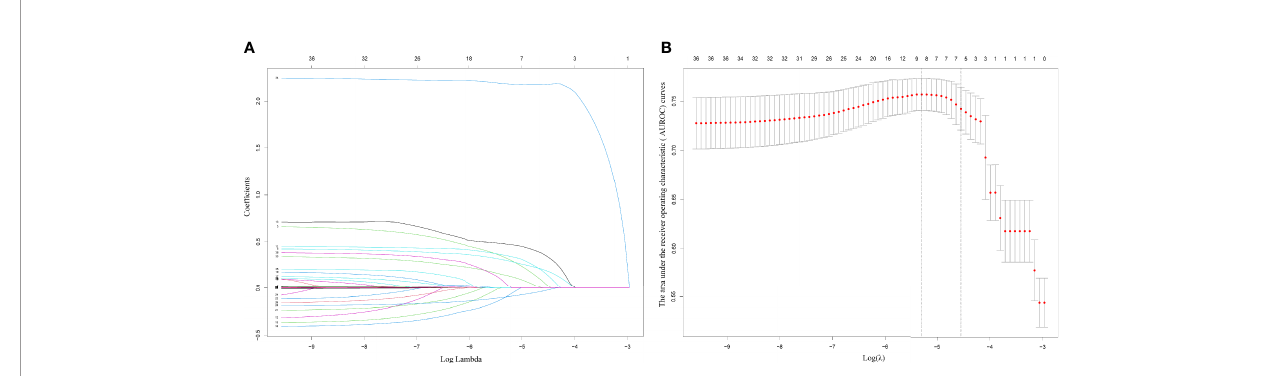
FIGURE 3 | Plots for LASSO regression coef fi cients over different values of the penalty parameter (A) . Cross validation plot for the penalty term (B)